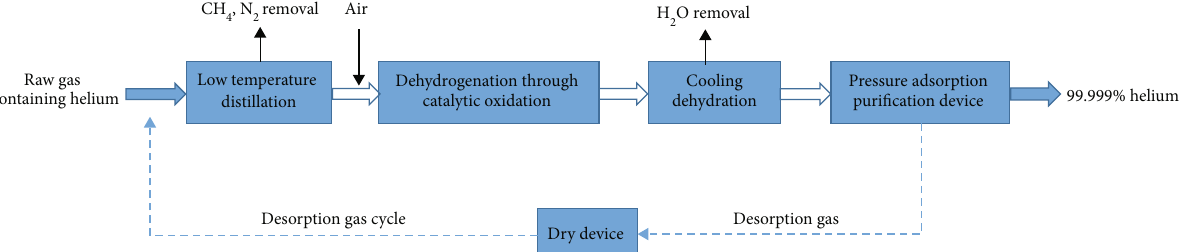
Figure 8: Helium extraction fl ow of the Qatar Ras La ff an helium plant [36].